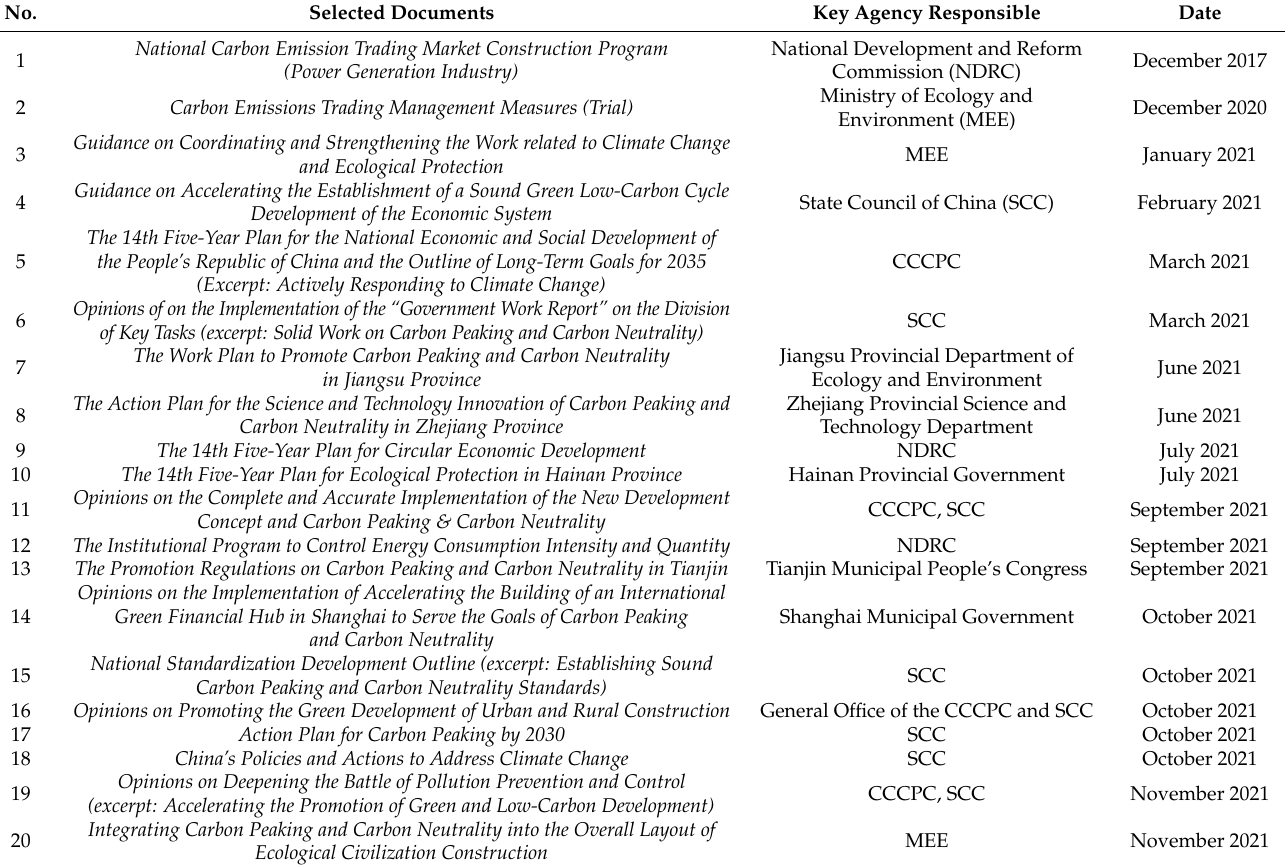
Table 3. Key carbon neutrality policies in